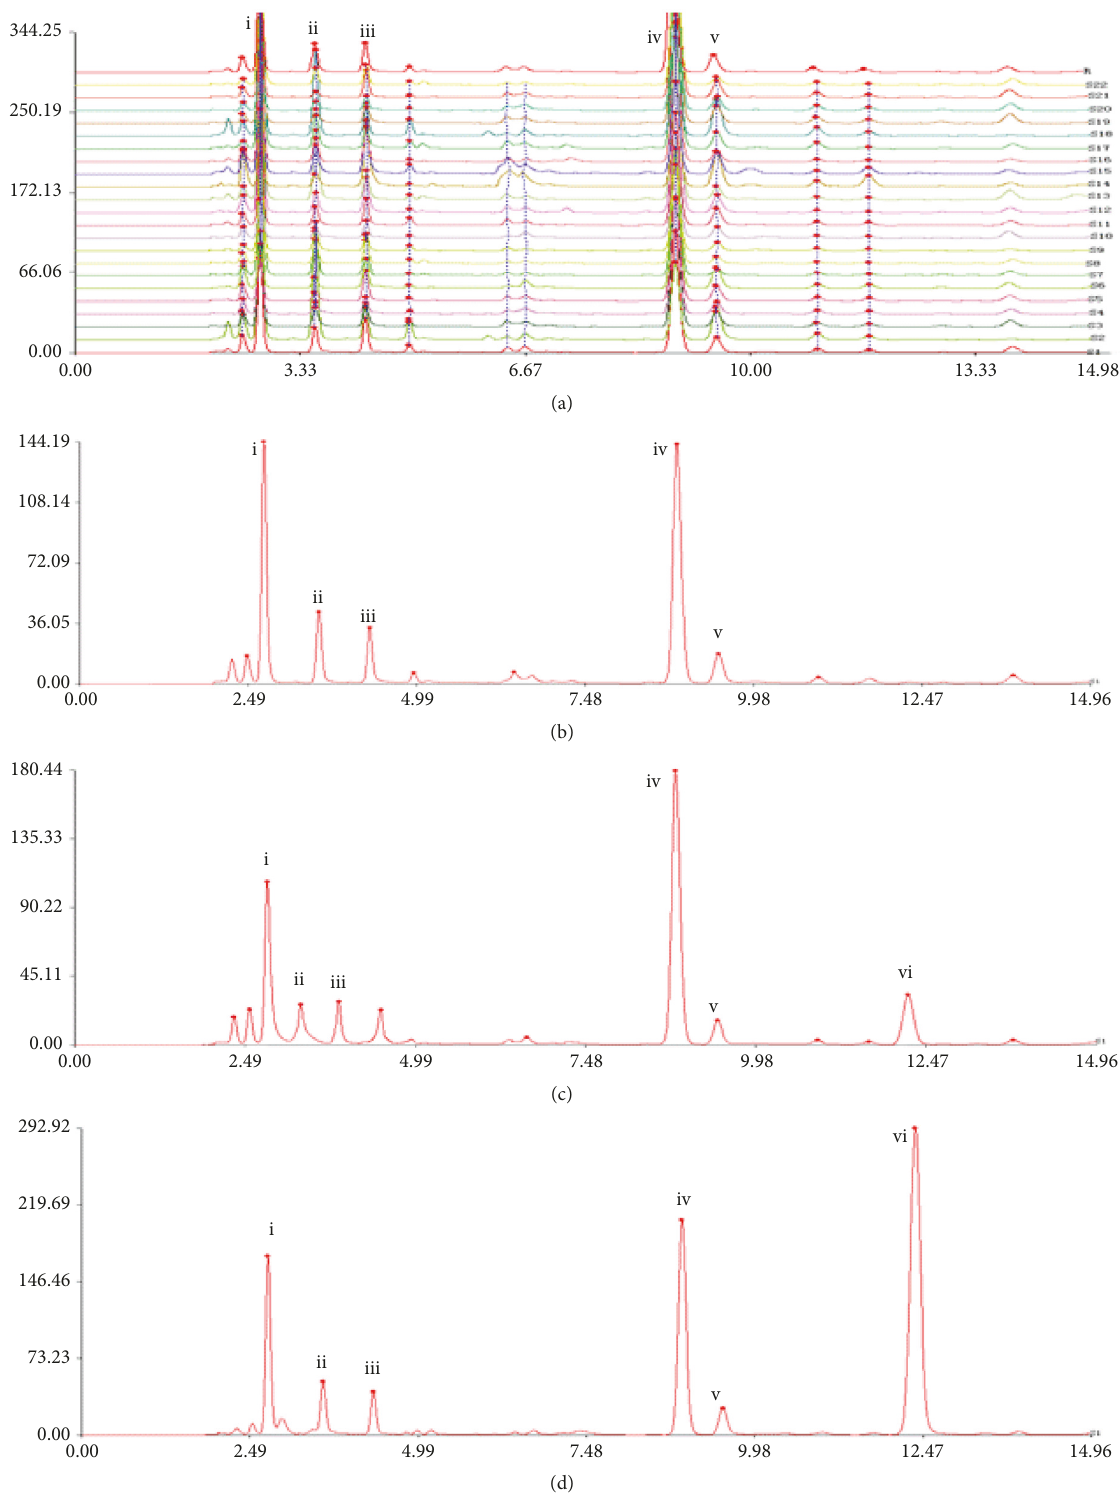
Figure 3: Fingerprint chromatograms of 22 batchessamples of P. aspergillum (a); P. aspergillum mutual pattern (b); M. magna mutual pattern (c); and A. obscuritoporus mutual pattern (d). (i) Hypoxanthine, (ii) xanthine, (iii) uridine, (iv) inosine, (v) guanosine, and (vi)